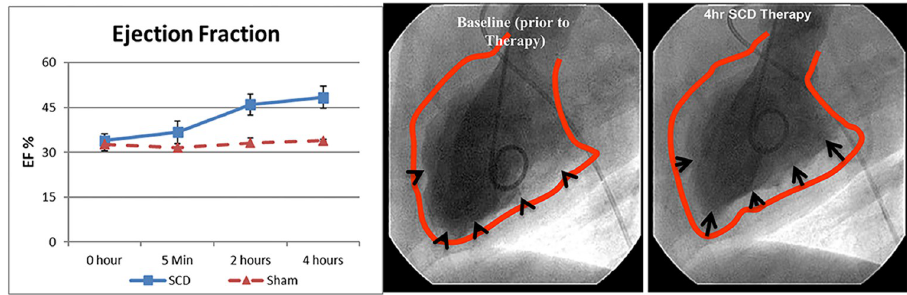
Fig 2. SCD treatment effects on cardiac performance in HF/HFrEF dogs treated for 4h with SCD (n = 3) or sham (n = 2). LVEF (Left Panel) was returned near normal levels of 50–55% under SCD treatment. No effect on EF with sham therapy with systemic heparin anticoagulation was observed. Ventriculograms of a HF dog heart (Right Panel) are shown at baseline (before therapy) and at the end of the 4h therapy session. The red line depicts the border of the diastolic silhouette overlayed on the systolic image, demonstrating improved contractility (black arrows) of the left ventricle after SCD treatment.